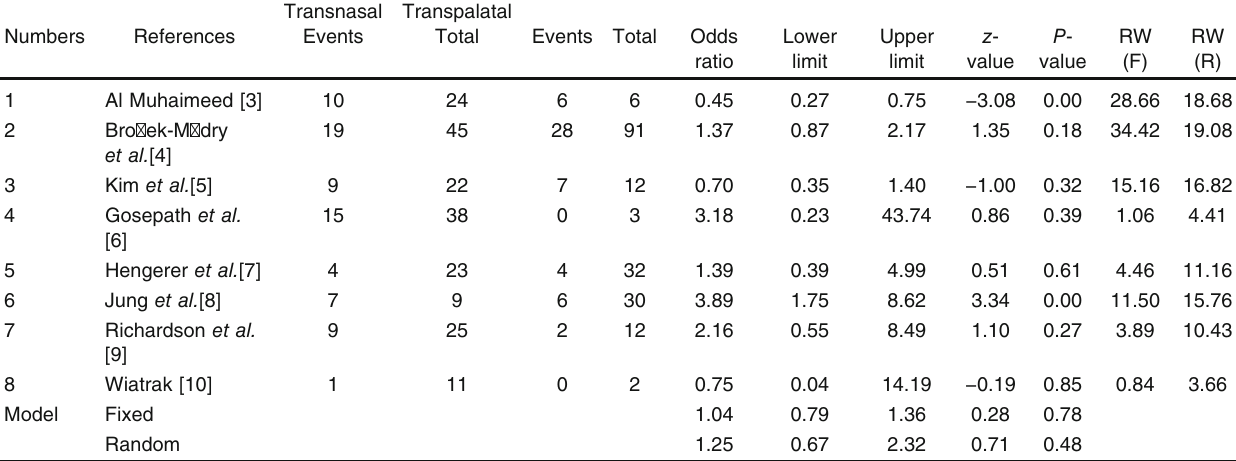
Table 4 Meta-analysis for the incidence of restenosis after transnasal or transpalatal repair using the estimated risk ratio as the effect measure